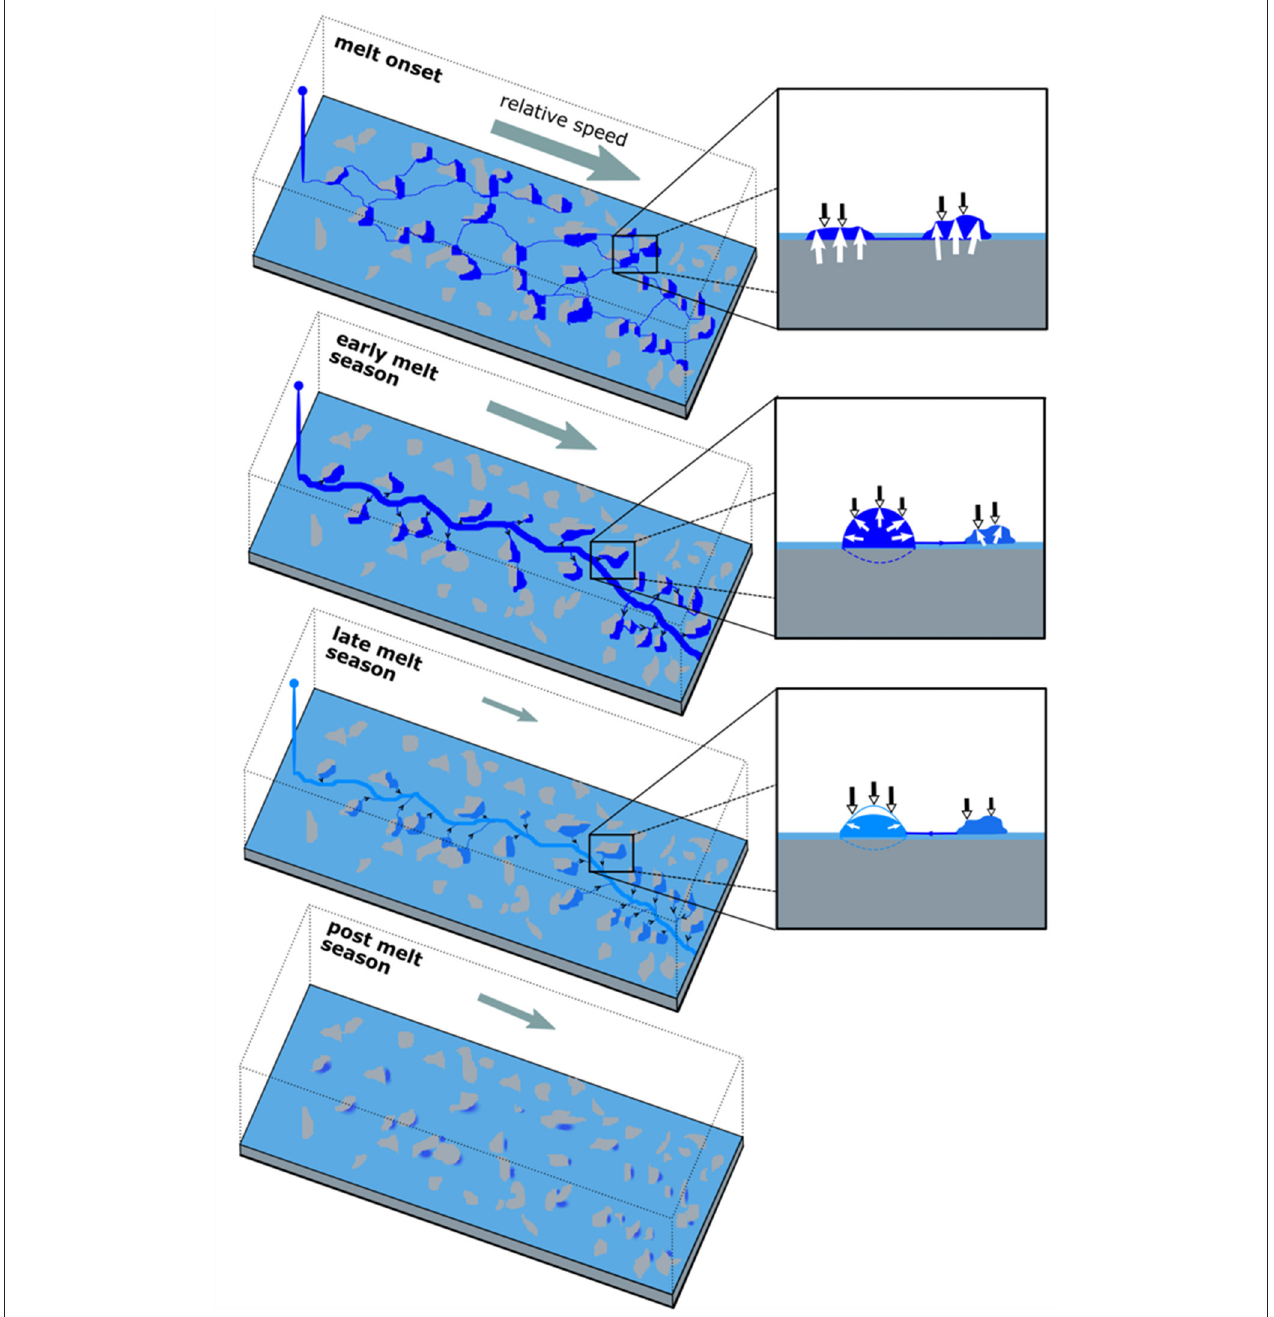
FIGURE 6 | Schematic of active drainage system hydrology-dynamic interactions. (Left) Black arrays indicate water flow direction. (Right) Cavity cross-sections—black and white arrows indicate closing and opening mechanisms, respectively. Size of grey arrow in left panels indicates relative velocity change from preceding period. Blue shading indicates basal water pressure (darker equals higher